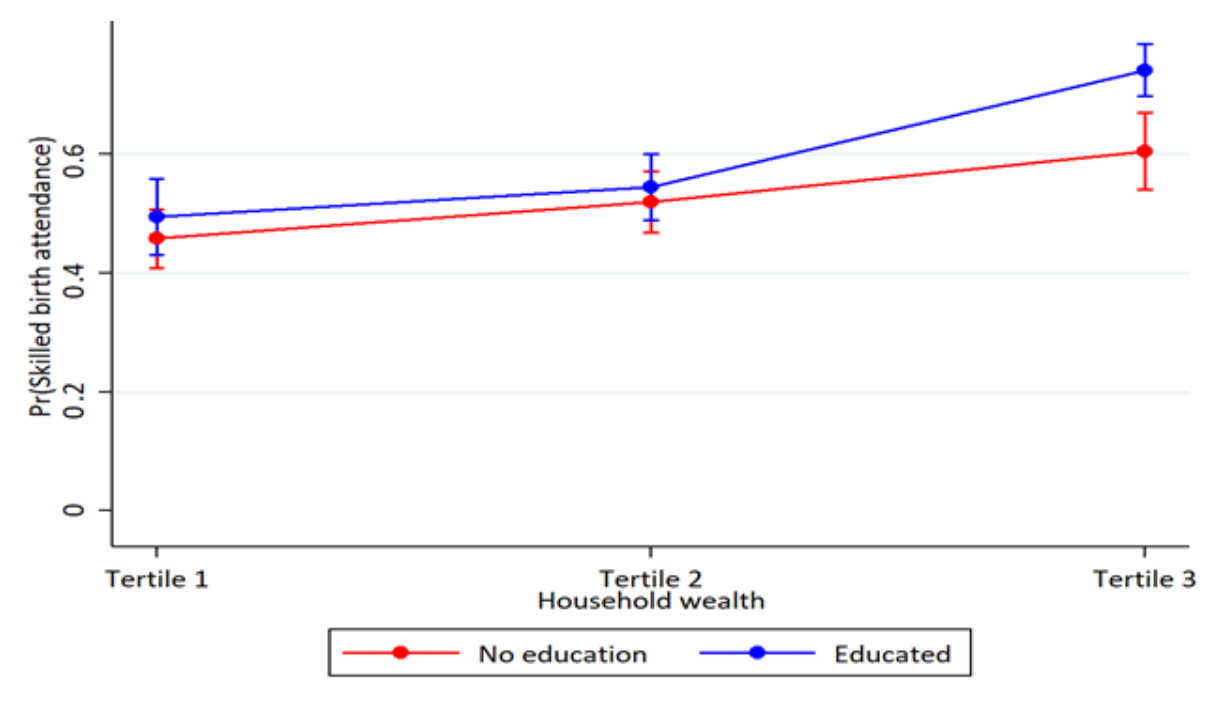
Figure 2. Probability of skilled birth assistance use by household wealth and maternal education with 95% confidence intervals.